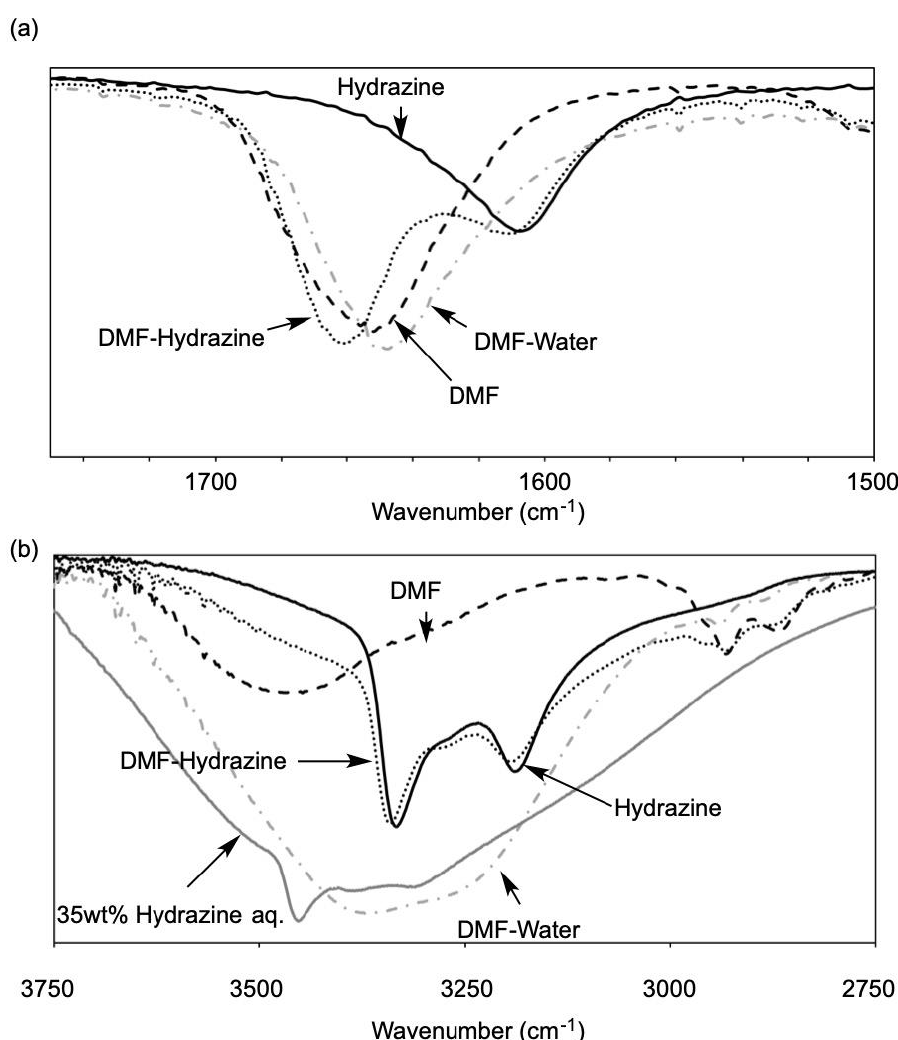
Figure 5. FTIR spectra of DMF, a mixture of DMF and hydrazine (v / v = 1 / 1), a mixture of DMF and water (v / v = 1 / 1), and hydrazine for ( a ) carbonyl and ( b ) N–H regions.